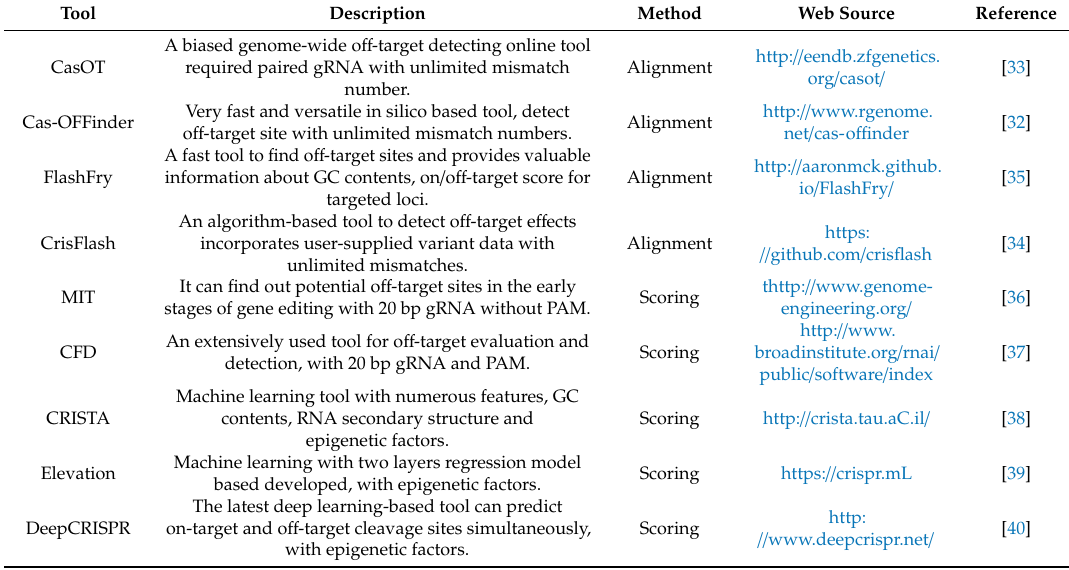
Table 2. Biased tools to detect and evaluate the guide RNA (gRNA) e ffi